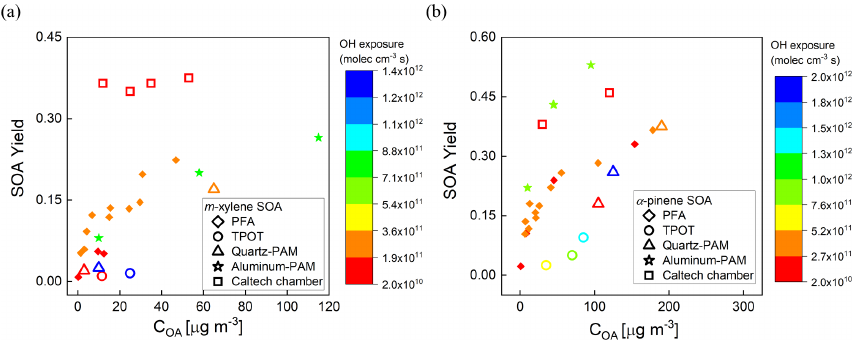
Figure 9. Comparison of SOA yields as a function of organic aerosol concentration ( C OA ) with those reported for other OFRs and one large Teflon chamber. (a) m -Xylene SOA and (b) α -pinene SOA. Marker color reflects the